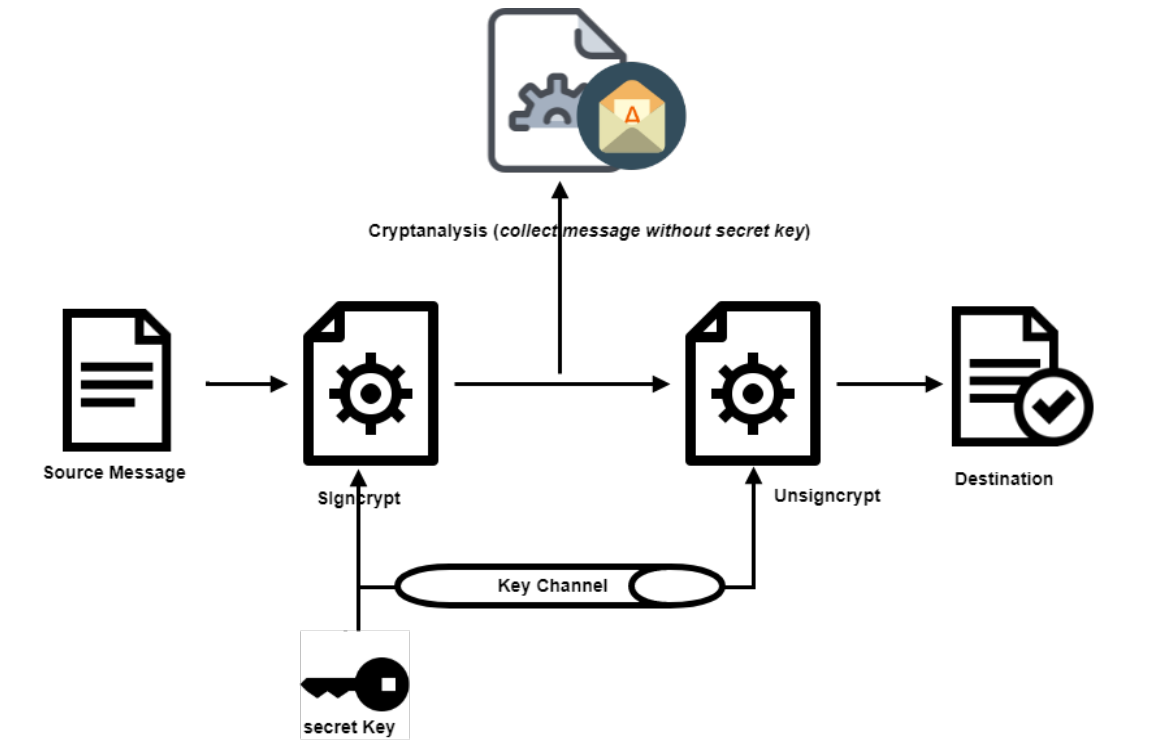
Figure 1. Cryptanalysis of a signcryption